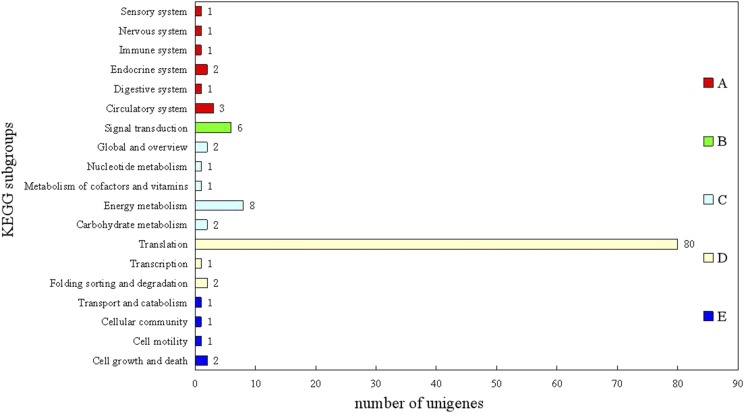
KEGG Orthology classifications of differentiallly expressed genes 117 KEGG annotated of 448 differential genes were classed into five groups: A: Organismal Systems; B: Environmental Information Processing; C: Metabolism; D: Genetic Information Processing; E: Cellular Processes. The y-axis represented subgroups. The x-axis represented number of unigenes.